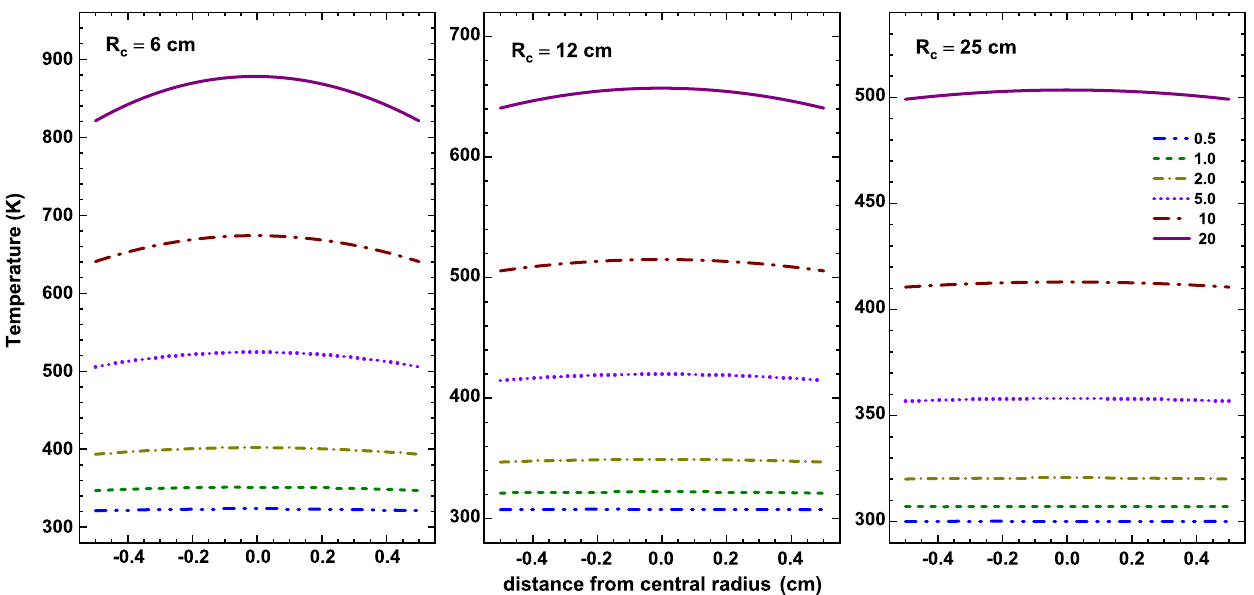
FIG. 18. Temperature distribution across the width annulus for the rotating targets with central radius R c ¼ 6 , 12, and 25 cm (panels from left to right) at the beam intensity varied within 0 . 5 − 20 p μ A (different lines). The pedestal temperatures for each distribution correspond to the mean values shown in Fig. 17 for rarefied H 2 (dashed lines in the figure panels), at which gas thermal conductivity values were used in the estimates of respective heating power